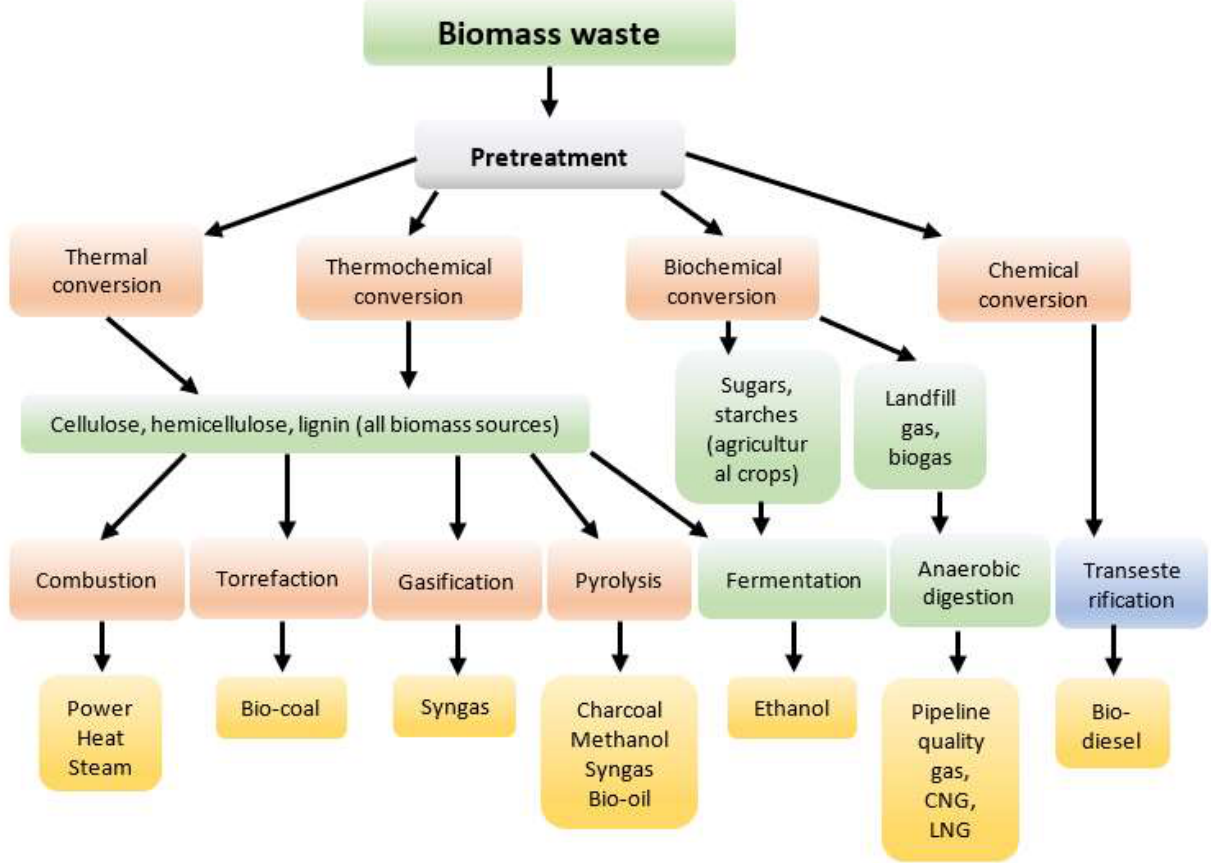
Figure 13. Biomass conversion into bioproducts [79–81].